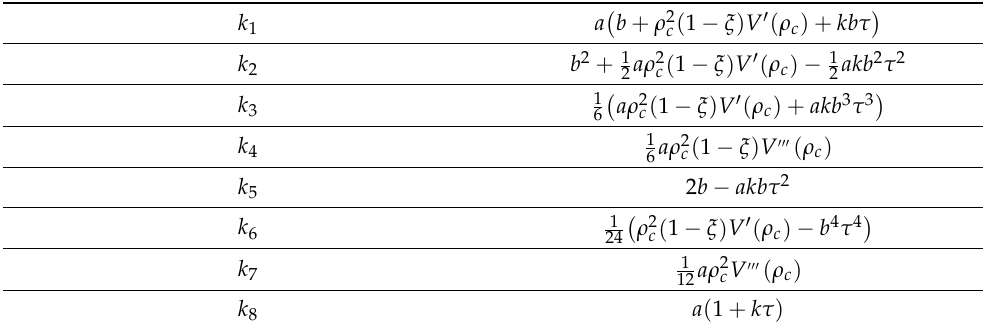
Table 1. The coefficients k i of the new model.